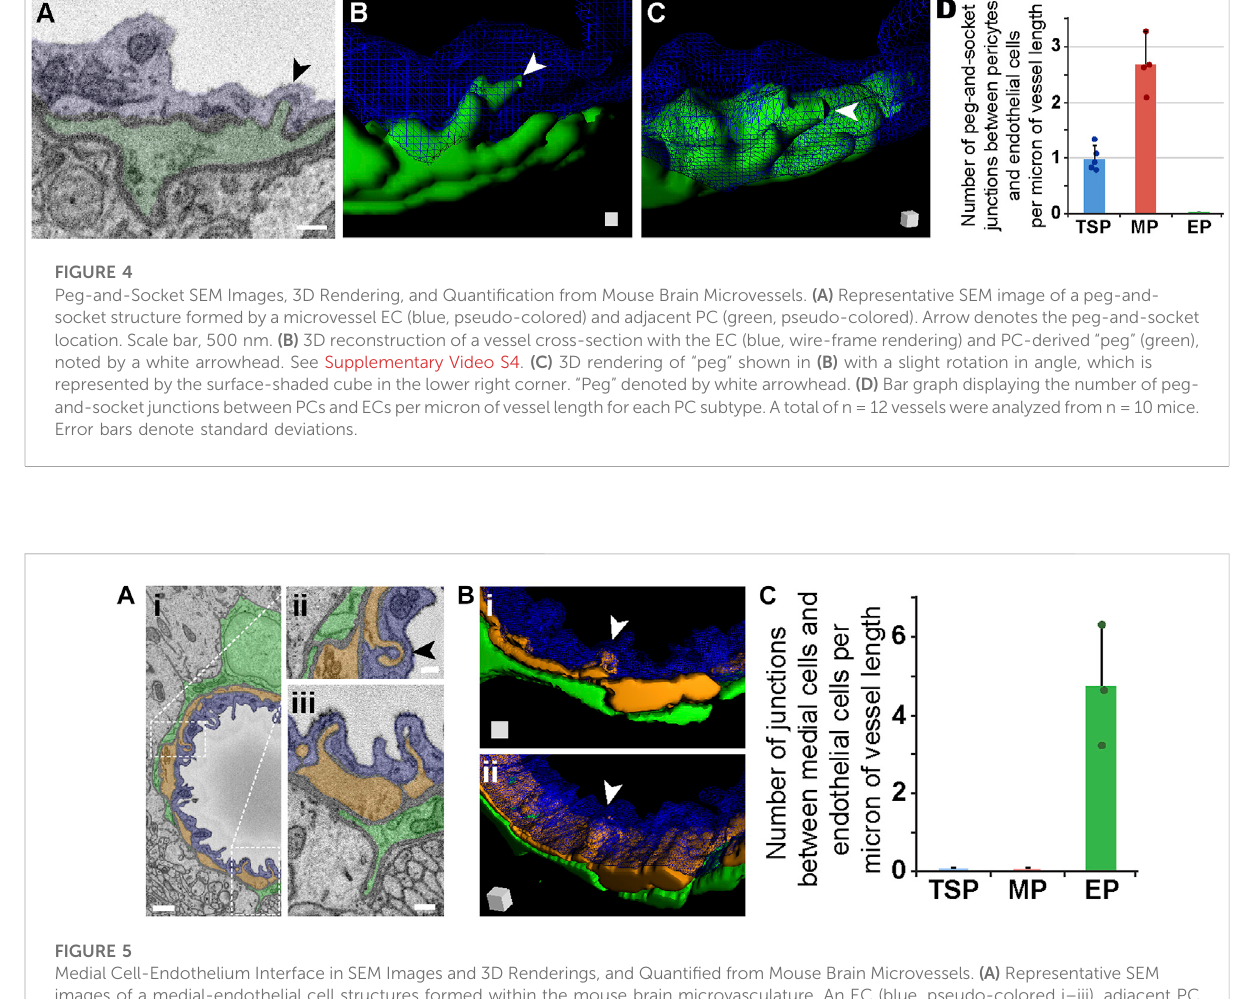
Medial Cell-Endothelium Interface in SEM Images and 3D Renderings, and Quanti fi ed from Mouse Brain Microvessels. (A) Representative SEM images of a medial-endothelial cell structures formed within the mouse brain microvasculature. An EC (blue, pseudo-colored i – iii), adjacent PC (green, pseudo-colored in i – iii), and medial cell (orange, pseudo-colored in i – iii) compose the vessel wall. White dotted rectangles denote wall regions shown in higher magni fi cation images in (ii) and (iii). Arrowhead in (ii) denotes a unique medial cell-EC interface further represented in (B) .Scalebarsin(i)is1 μ m,andin(ii)and(iii)is250 nm. (B) 3Dreconstructionofavesselcross-sectionwiththeEC(blue,wire-framerenderingini-ii), medial cell-derived structure (orange in i-ii) noted by a white arrowhead, and an associated EP (green in i-ii). See Supplementary Videos S5, S6. The 3D rendering of the medial-endothelial cell structure shown in (ii) is at a slight rotation in angle, which is represented by the surface-shaded cube in the lower left corner. (C) Bar graph displaying the number of medial cell-EC junctions per micron of vessel length for each PC subtype. A total of n = 12 vessels were analyzed from n = 10 mice. Error bars denote standard